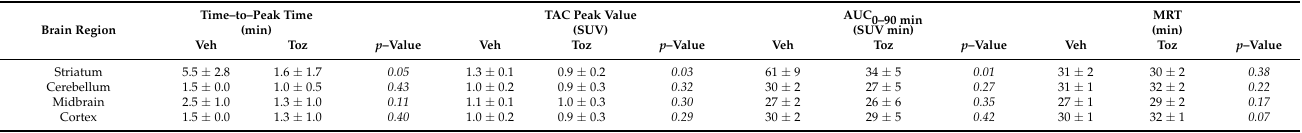
Figure 5. [ 18 F]FLUDA mean time–activity curves in standardised uptake values (SUV; black lines) and corresponding first moment curves (grey lines) in different brain regions of pigs with (solid lines, circles) and without (dashed lines, triangles) injection of tozadenant. ( A ) striatum, ( B ) cerebellum, ( C ) cortex, and ( D ) midbrain; n = 3, mean ± SD. Table 6. Parameters derived from the non–compartmental analysis of the time–activity curves of [ 18 F]FLUDA in different brain regions of pigs treated with (toz) and without (veh) the A 2A AR specific antagonist tozadenant.